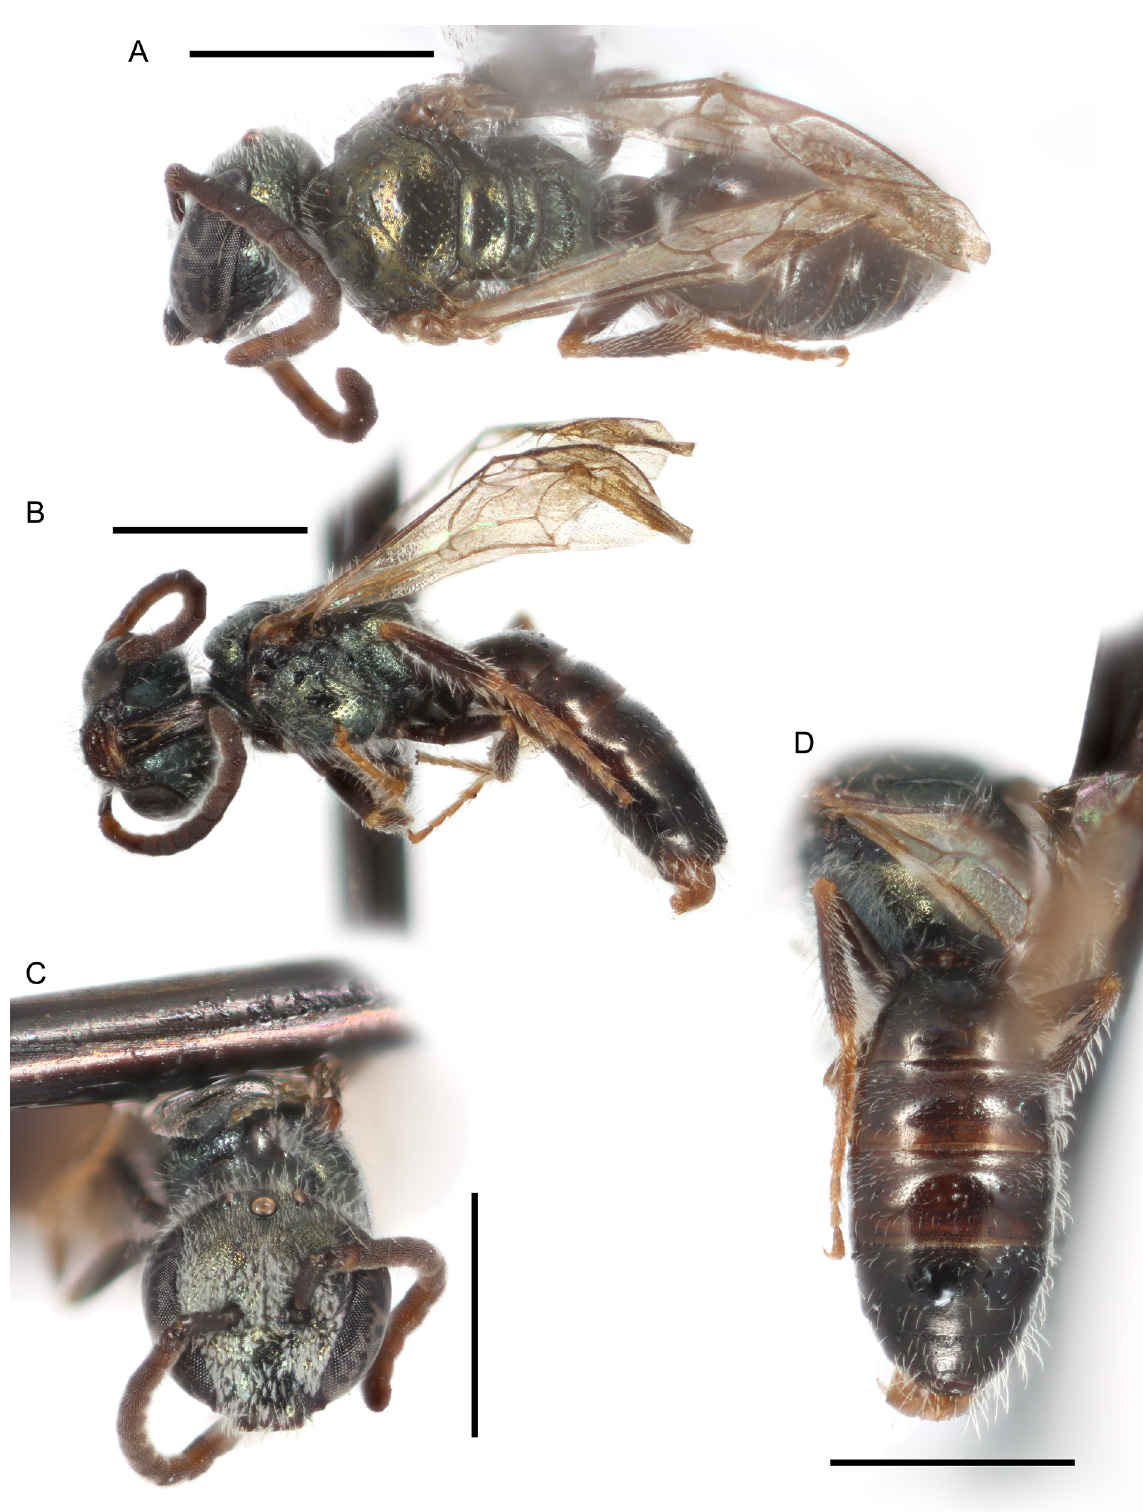
Fig. 59. Lasioglossum ( D. ) meteorum sp. nov., ♂. A . Dorsal habitus. B . Lateral habitus. C . Face. D . Metasoma. Scale bars: 1